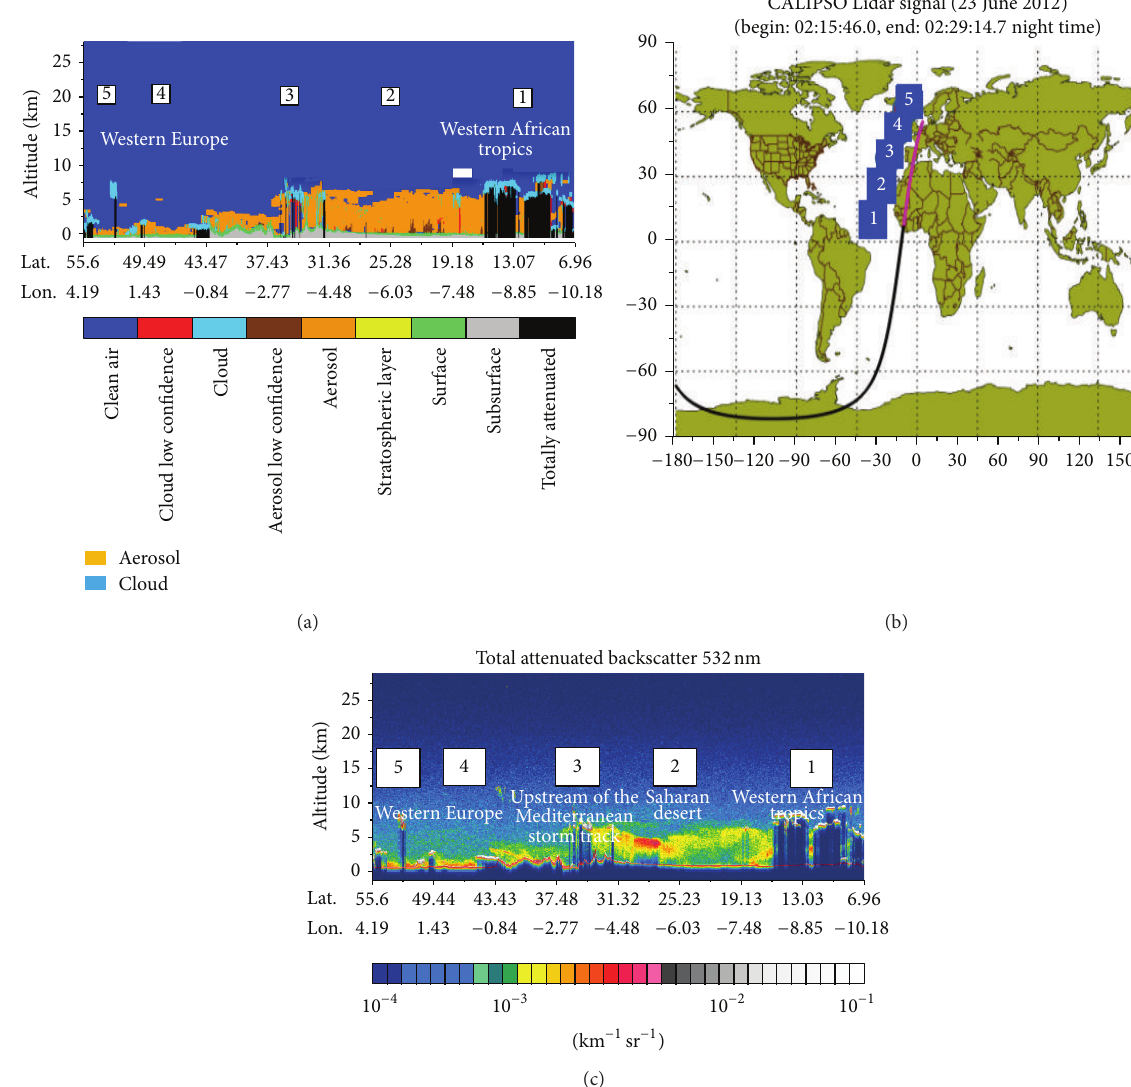
Figure 7: (a) Vertical feature mask shows the CALIPSO aerosol subtypes. (b-c) Total attenuated backscatter at 532 nm along with the orbit track (b) (km −1 sr −1 ); the colour bars for attenuated backscatter show the colors assigned to ranges of attenuated backscatter, km −1 sr −1 ; the vertical axes are annotated to indicate altitude in kilometers; the horizontal axes are annotated with latitude in kilometres (deg) and longitude